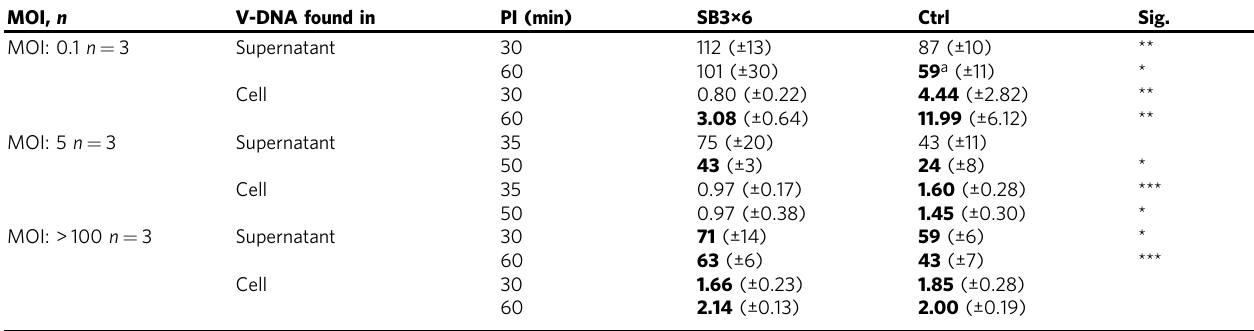
Table 1 Relative amounts of SSV1 virus DNA of silenced and control cultures infected at different MOIs MOI, n V-DNA found in PI (min) SB3×6 Ctrl